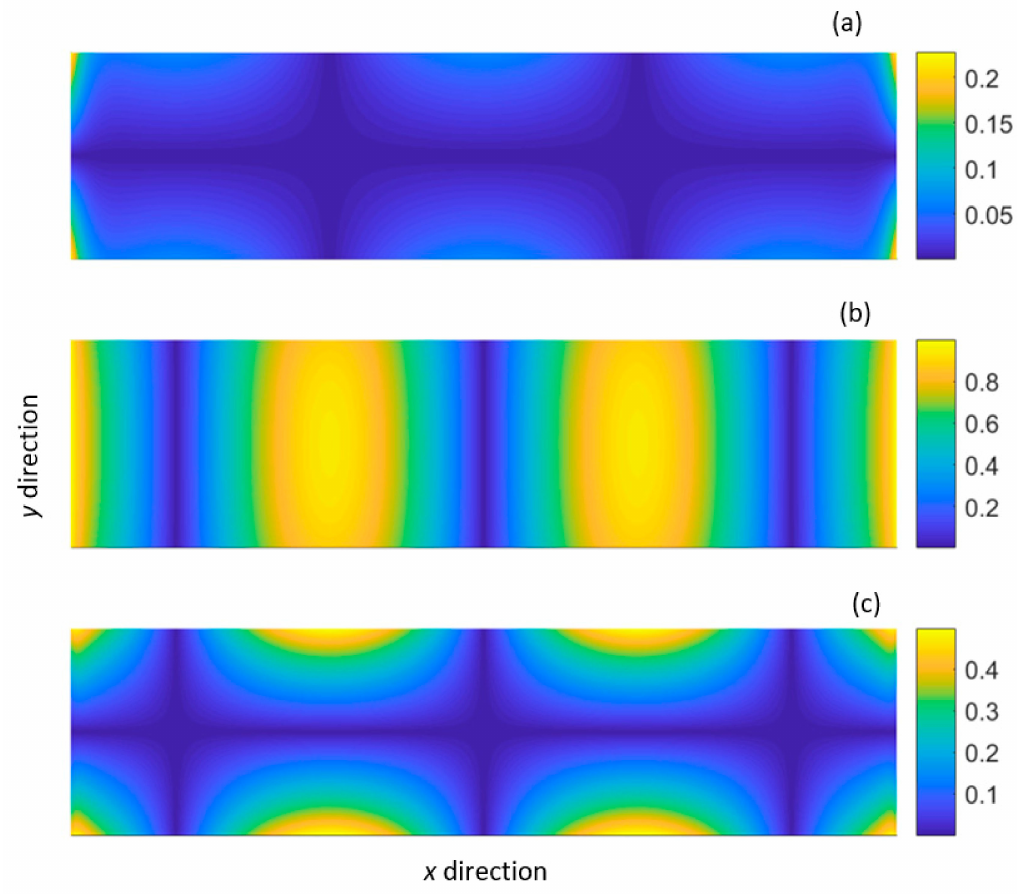
Figure 12. Normalised displacement distribution of the F2* mode: ( a ) shear displacement ( x direction); ( b ) vertical displacement ( y direction); ( c ) extensional displacement ( z